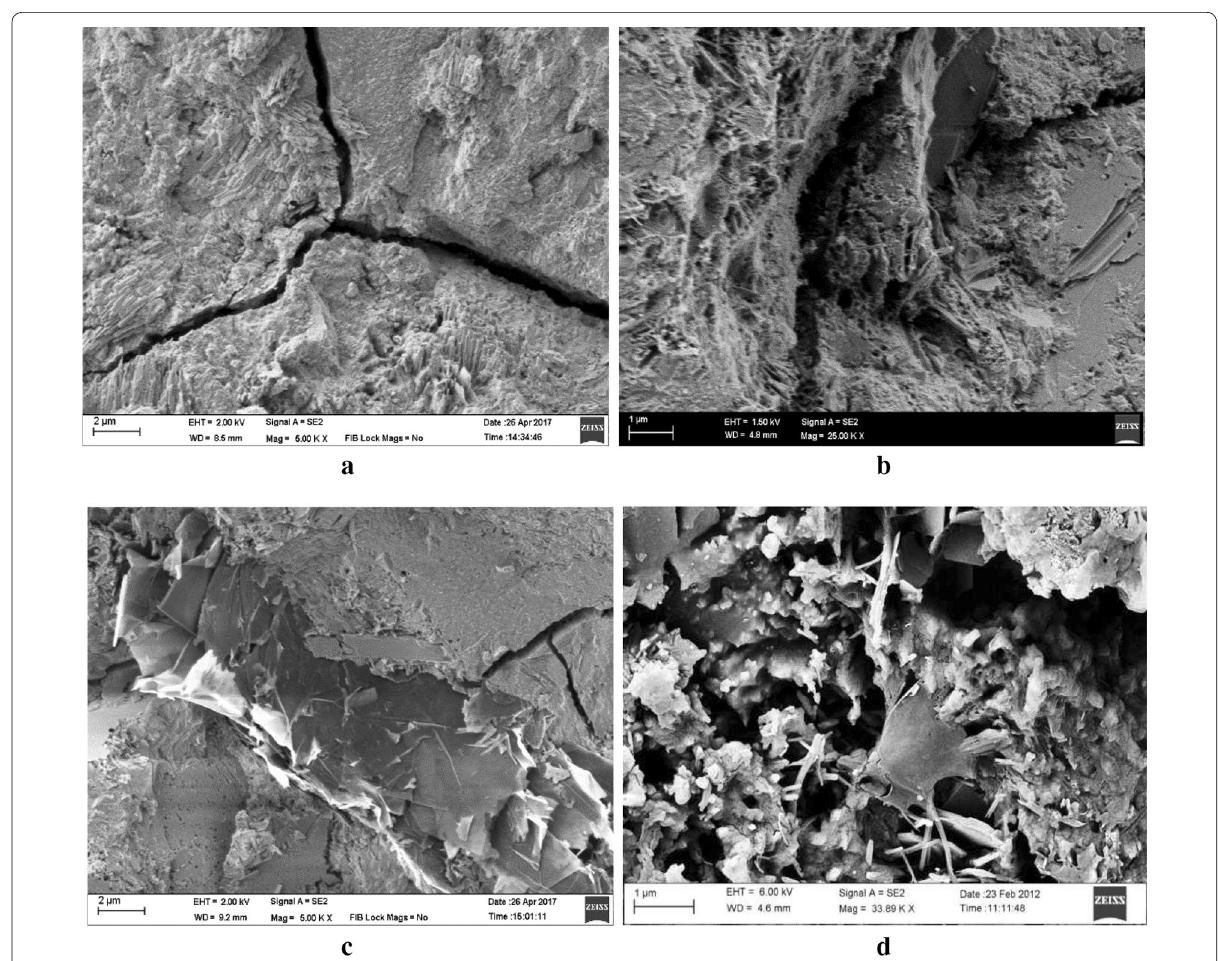
Fig. 7 a Propagation of crack in plain cement. b Crack bridging phenomena by graphene. c Crack blocking phenomena by graphene (Rehman et al. 2017). d Crack bridging in graphene cement composite (Zohhadi